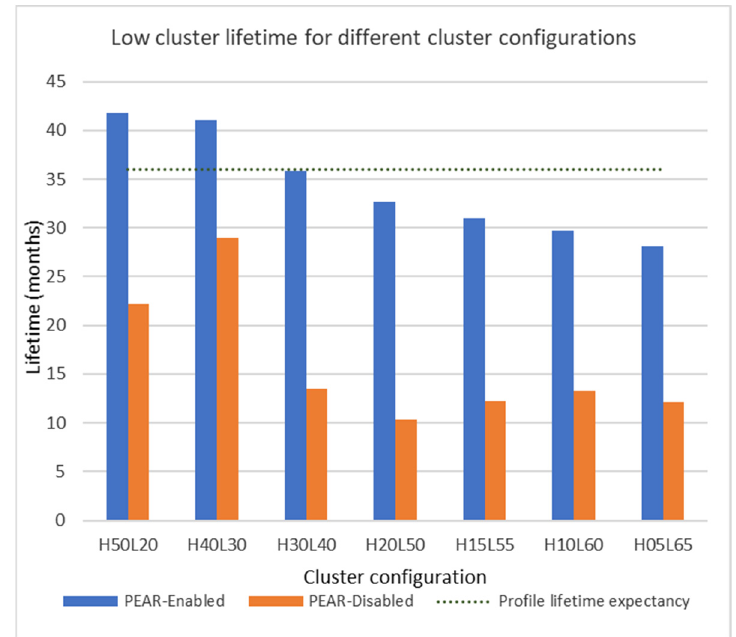
Figure 12. Comparison between PEAR-Enabled and PEAR-Disabled low cluster lifetime for different cluster configurations. Table 5. The PEAR and Non-PEAR cluster overconsumption per test configuration.